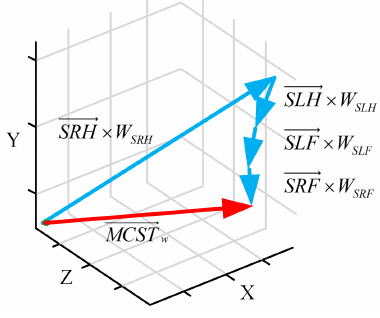
Figure 4. The final MCSTV.